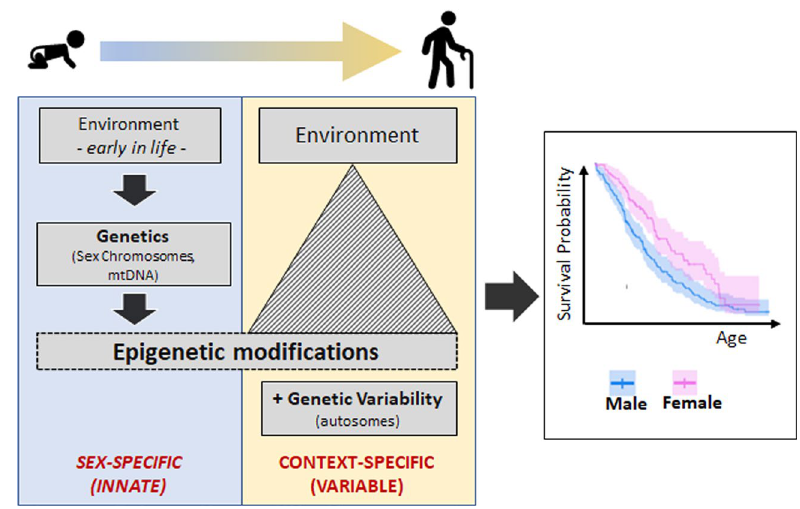
Fig. 2 Genetic and epigenetic determinants of sex differences in